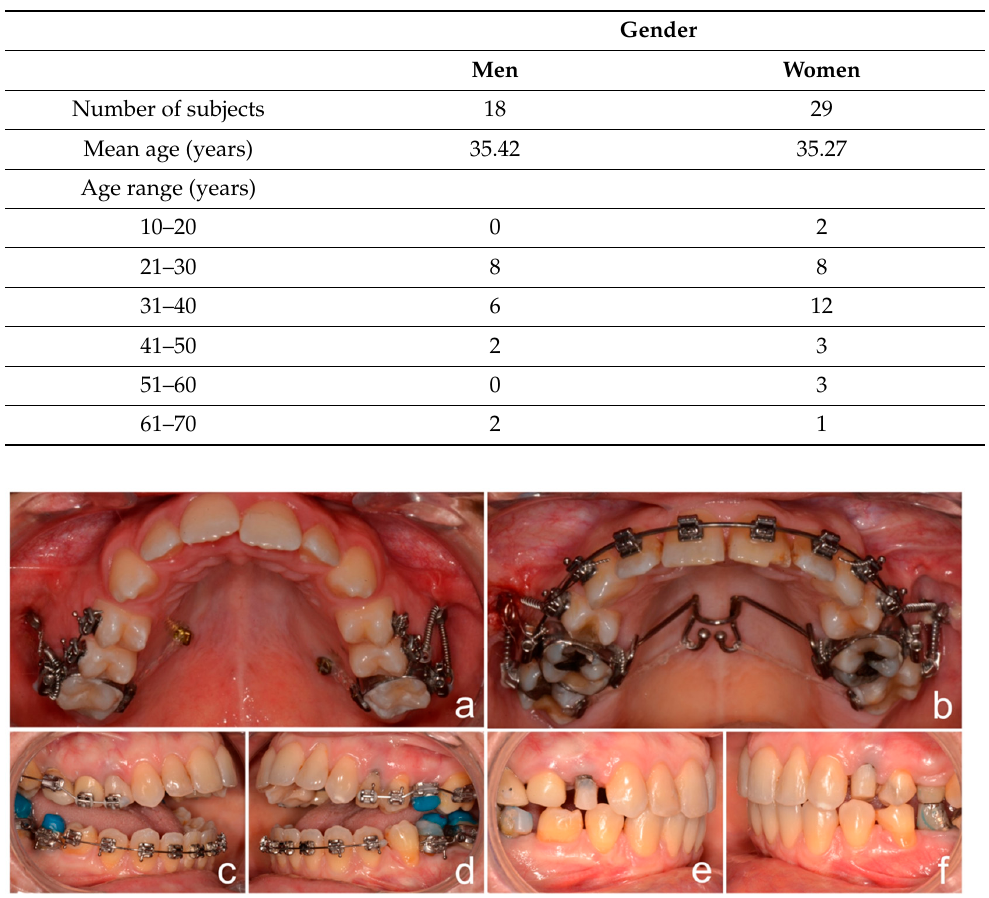
Table 1. Age and gender distribution of the subjects.